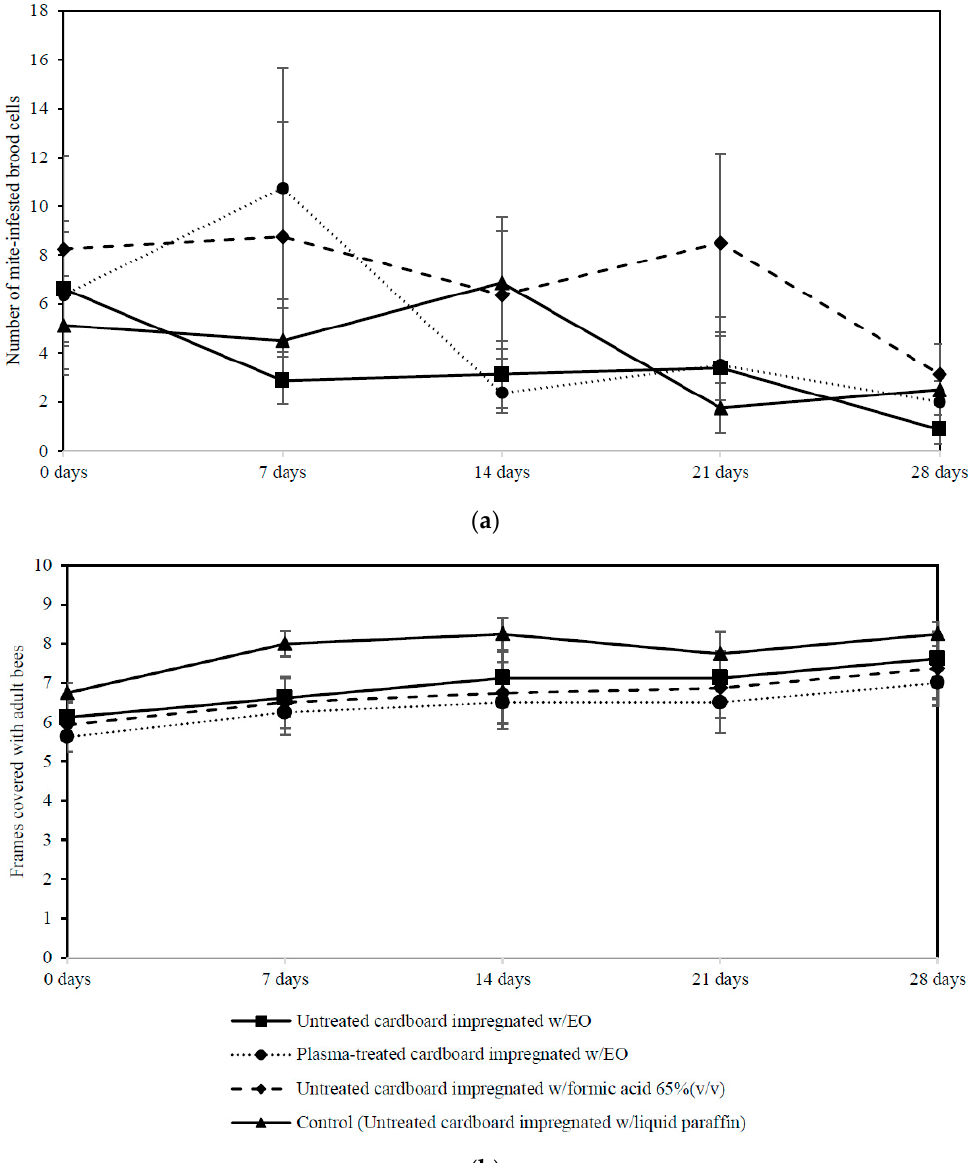
Figure 6. Number of mite-infested brood cells ( a ) and average number of frames covered with adult bees ( b ) in honey bee colonies ( n = 9/treatment group) after A. krervanh EO treatment using plasma-treated cardboard (5% ( w / v )) compared to controls (untreated cardboard impregnated with EO and untreated cardboard impregnated with liquid paraffin) and untreated cardboard impregnated with formic acid (65% ( v / v )) at each observation period (before treatment and at 7, 14, 21 and 28 days after treatment) (Kruskal-Wallis H and Steel-Dwass test, p >